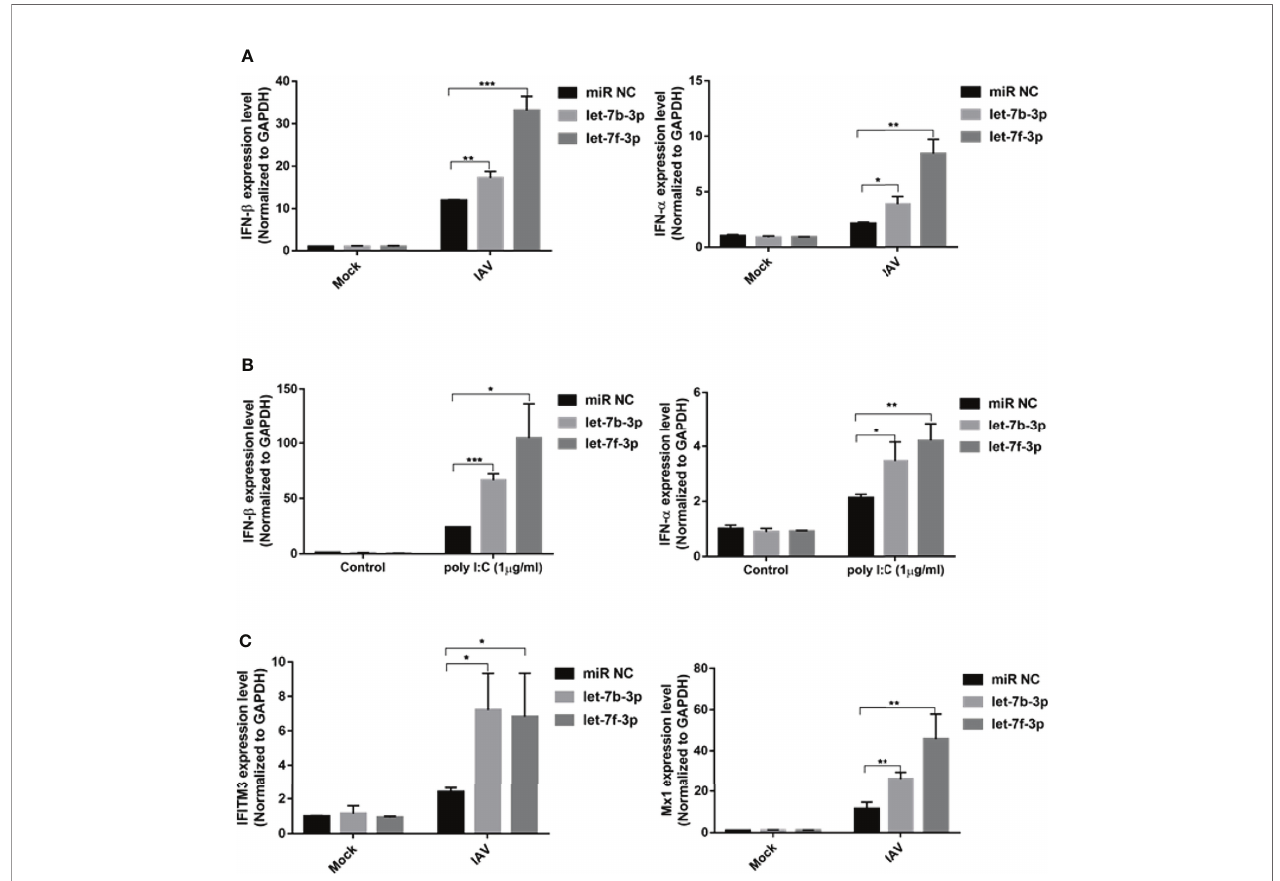
FIGURE 5 | Let-7 upregulates IAV-triggered type I IFN induction. A549 cell was transfected with the mimics of hsa-let-7b-3p, hsa-7f-3p or negative control (miR NC). (A) At 48h post transfection, the cells were infected with in fl uenza A/WSN/1933 virus (MOI=1) for 12h, the expression of IFN- b and IFN- a were detected by real-time qPCR and normalized to expression of GAPDH; (B) At 48h post transfection, the cells were transfected with poly I:C (1µg/ml) for 12h, the expression of IFN- b and IFN- a were detected by real-time qPCR and normalized to expression of GAPDH. (C) At 48h post transfection, the cells were infected with in fl uenza A/ WSN/1933 virus at 1 of MOI for 12h, the expression of IFITM3 and Mx1 were detected by real-time qPCR and normalized to expression of GAPDH. Data were shown as mean ± SD (* p < 0.05, ** p < 0.01, *** p < 0.001). Data are the representative of three independent